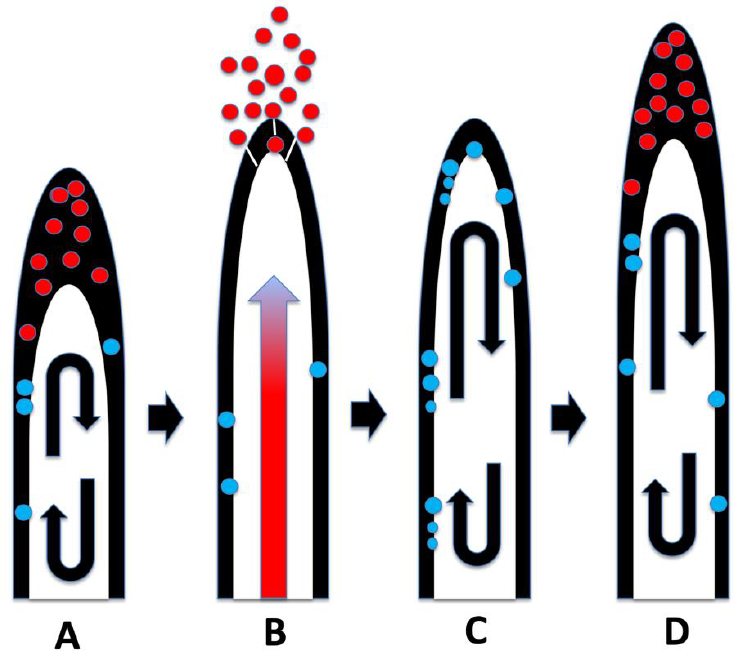
Figure 19. Diagrammatic representation of root hair microbe protoplast ejection. Microbes in tips are red to indicate superoxide exposure and nitrogen extraction; microbes cycling in hairs are blue to indicate replication and nitrogen fixation. ( A ) Cyclosis moves microbes to the periplasmic space at the top of the hair where they accumulate and secrete ethylene en mass . ( B ) Microbial ethylene triggers a growth spurt in the hair which manifests as an expansion wave that propagates from the base to the tip of the hair. The expansion wave (red arrow) causes growth in the hair and forces out the bacteria accumulated in the hair tip. ( C ) The remaining bacteria are taken back into the cyclosis stream and replicated. ( D ) As bacteria populations rebuild in root hairs, they again accumulate in the hair tips, subsequently triggering another ejection event.